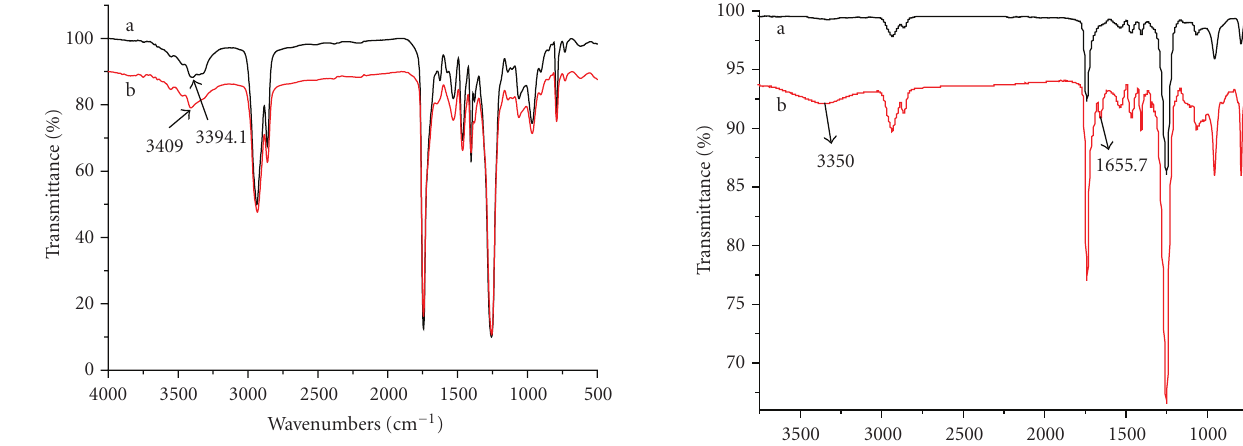
Figure 2: FT-IR spectra of PU (a) and PU-NH 2 (b).